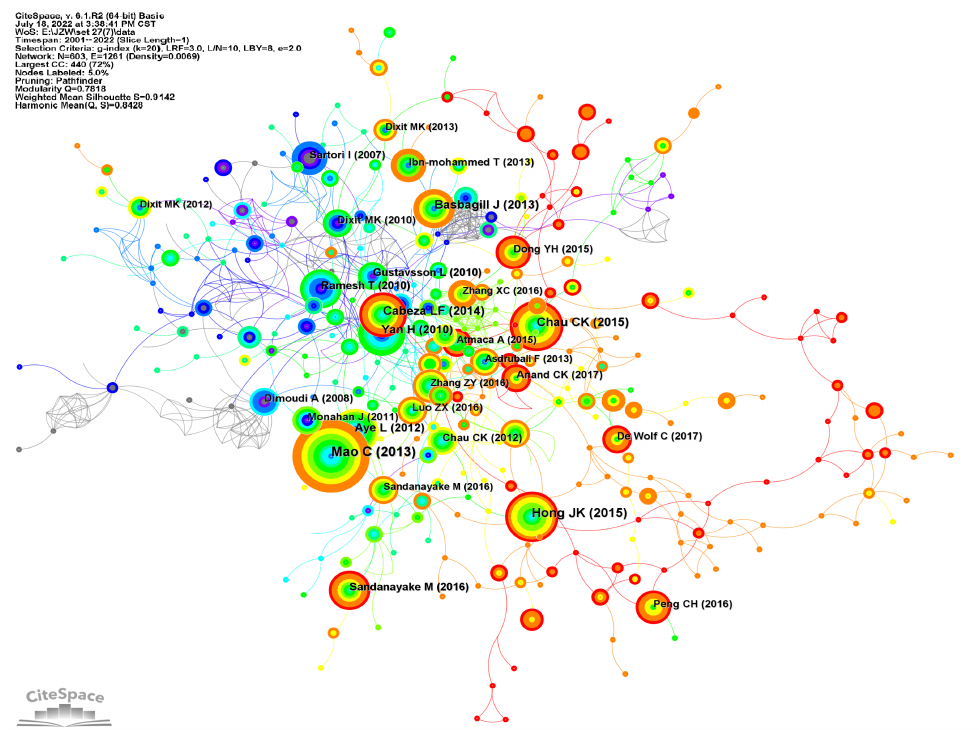
Figure 6. Documents co-citation network.